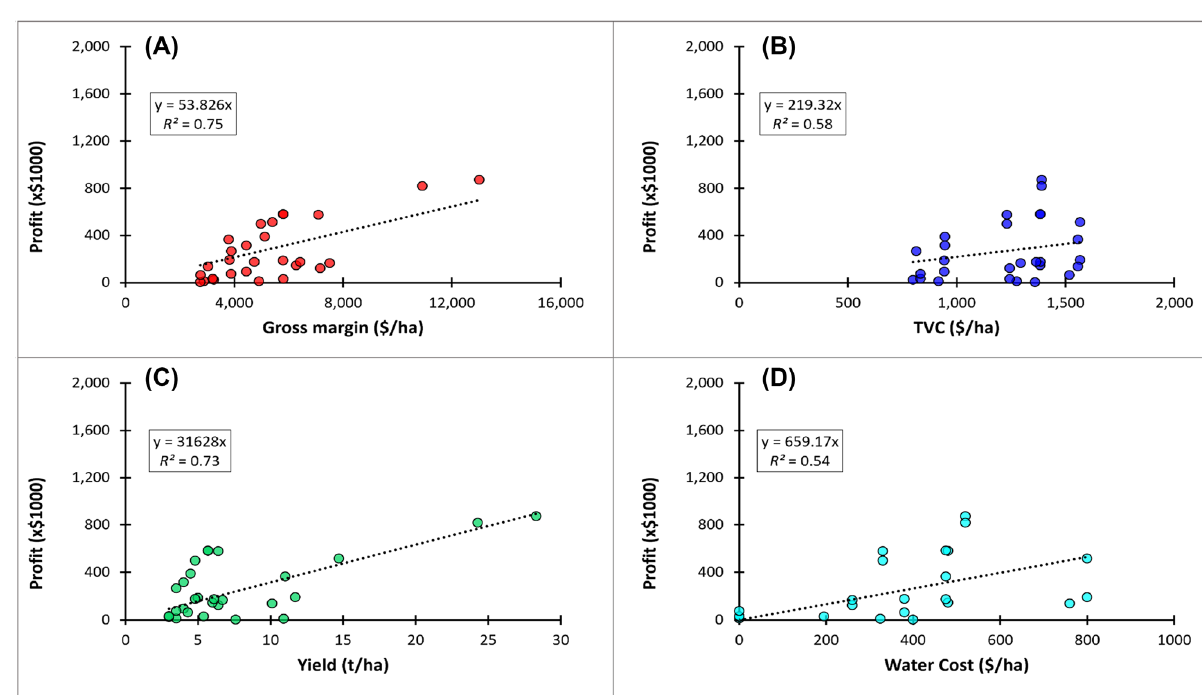
Figure 10. Relationships between profit and gross margin ( A ), total variable costs ( B ), yield ( C ) and water costs ( D ) at high prices for the most profitable whole farm systems across representative environments in irrigated grain regions of Australia under historical and future